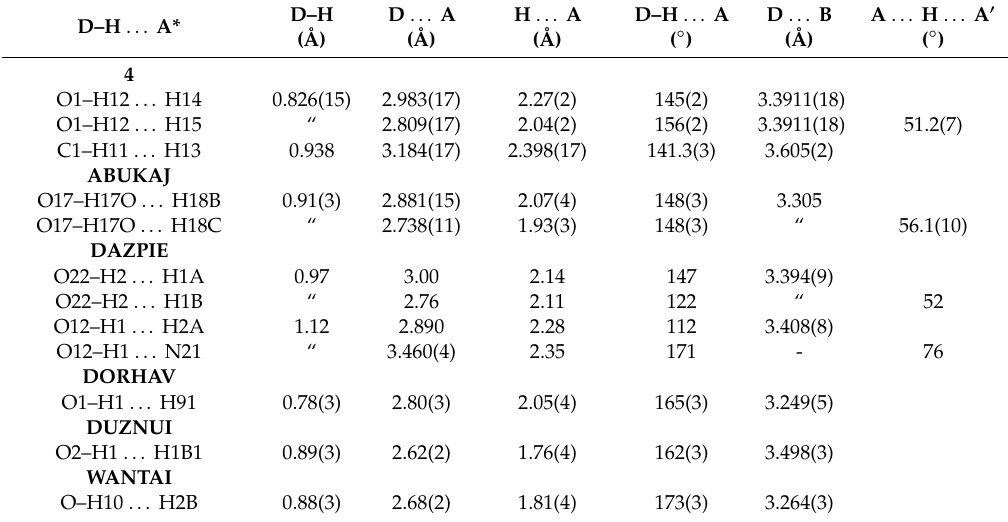
Table 2. Aminoborane group comparison with published results.